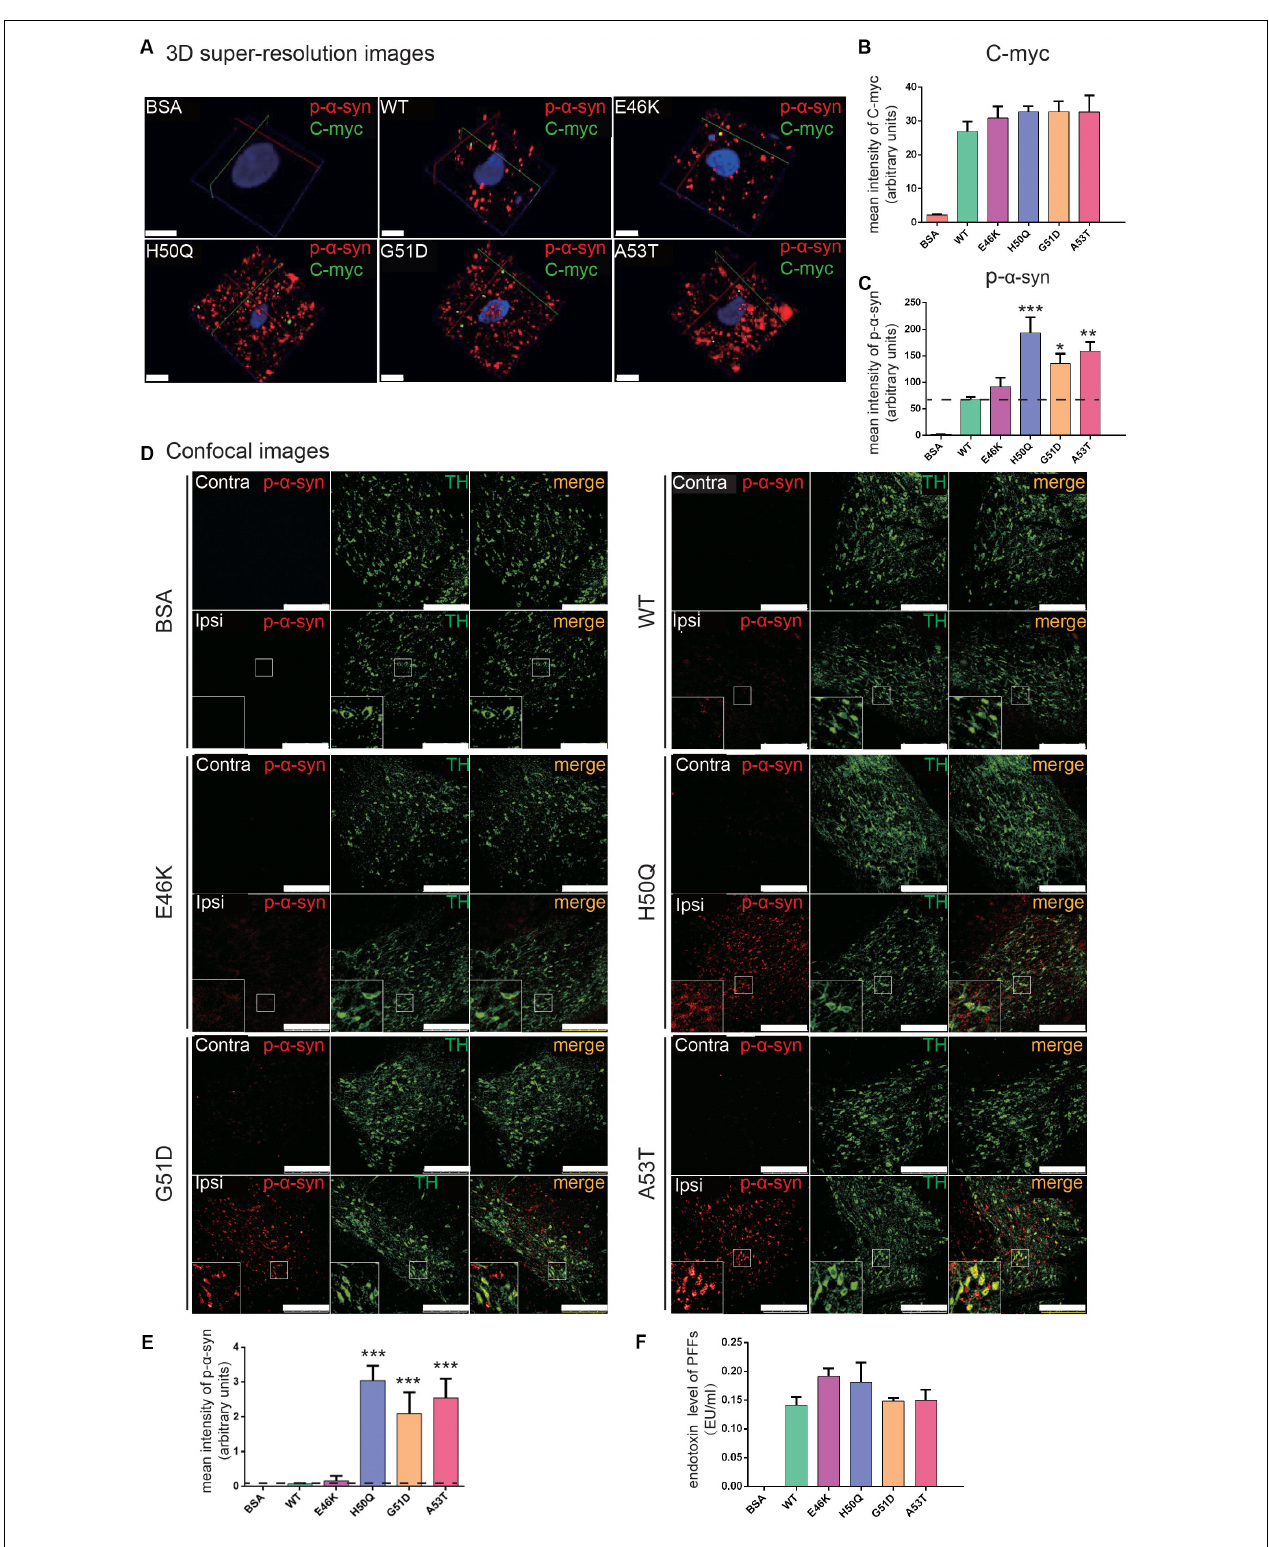
FIGURE 6 | PFFs induce phosphorylation of endogenous α -syn in dopaminergic neurons. (A) 3D super-resolution images of internalized PFFs (C-myc, green) co-stained with endogenous p- α -syn (red) 24 h after injection (scale bars, 5 µ m). (B,C) Mean intensity of C-myc (B) and p- α -syn (C) in 3D super-resolution images. (D) Confocal images of TH (green) co-stained with p- α -syn (red) (scale bars, 250 µ m). (E) Mean intensity of p- α -syn in confocal images as in (D) . (F) Endotoxin levels in microinjected samples. Mean ± SEM; * P < 0.05, ** P < 0.01, *** P < 0.001, one-way ANOVA followed by Dunnett’s test compared to WT; n = 6 animals.